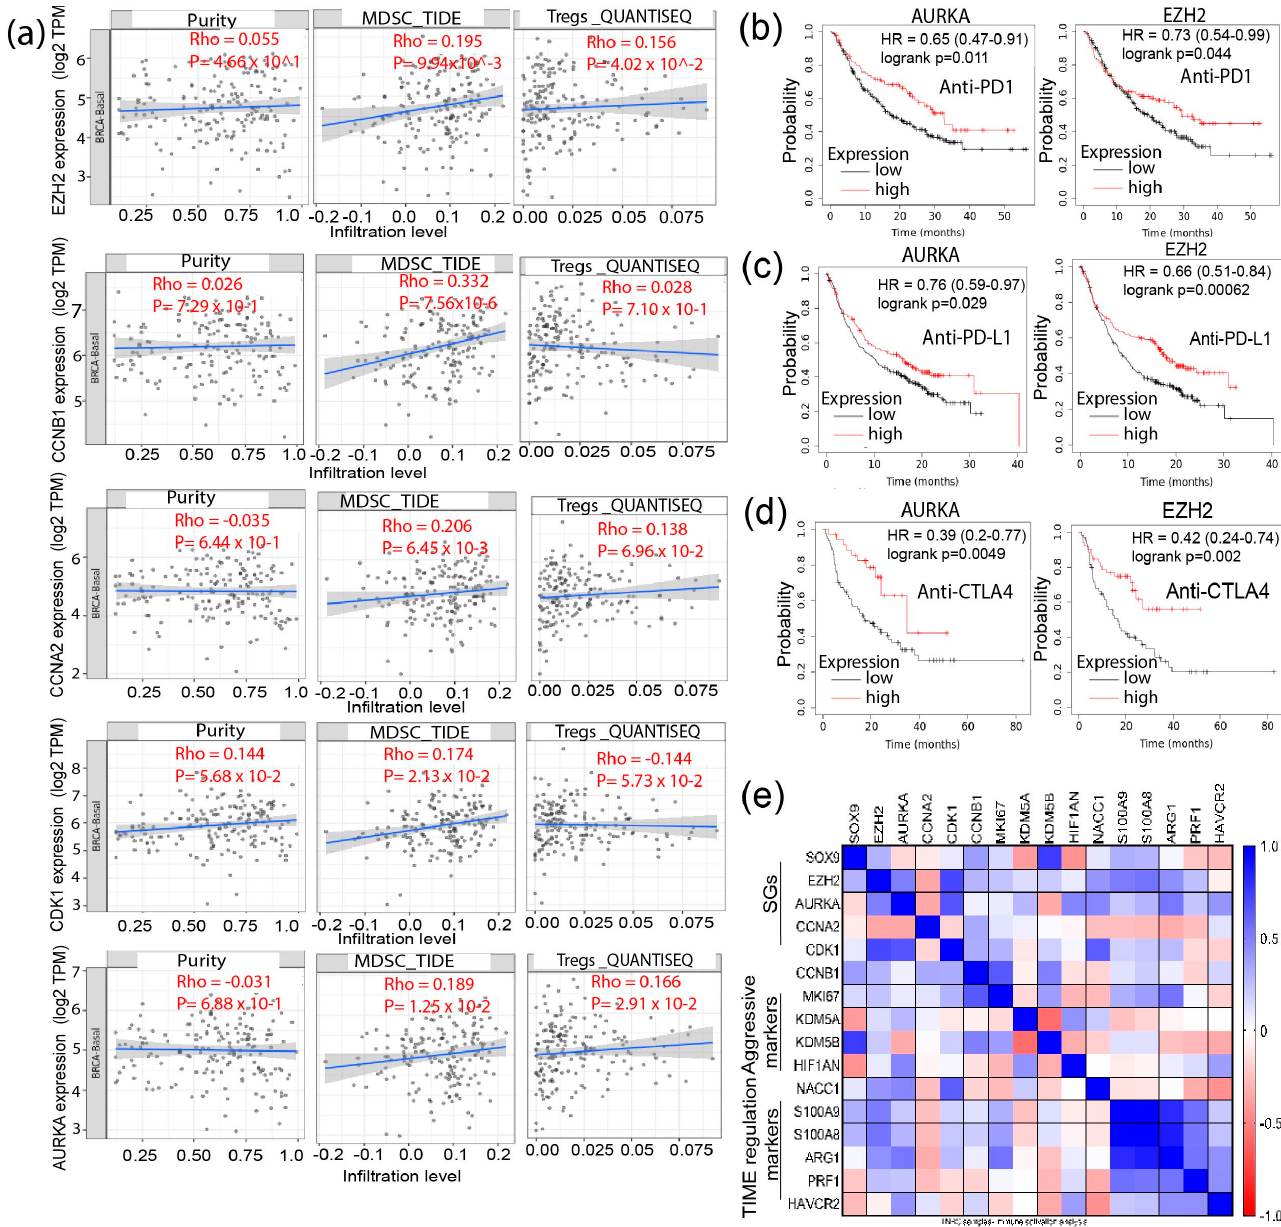
Figure 5. Association of the stemness-associated genes with immune cell in fi ltration and immuno- suppressive markers in TNBC. Correlation of the gene expressions with immune cells in fi ltration was analyzed using the Timer2.0 online platform. ( a ) Correlation of MDSCs and Tregs in fi ltration